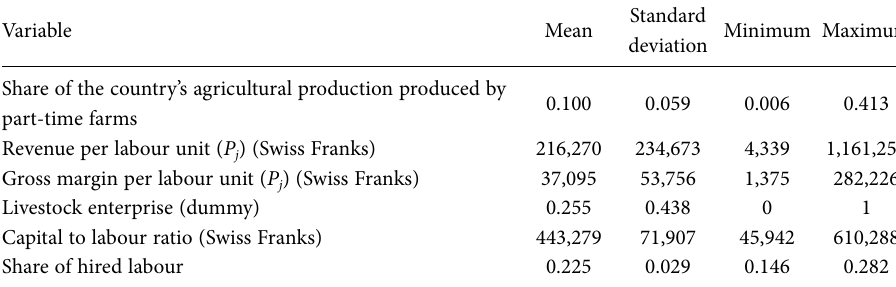
Table 1. Descriptive statistics of the aggregated data used: 16 enterprises in 1996-2004.